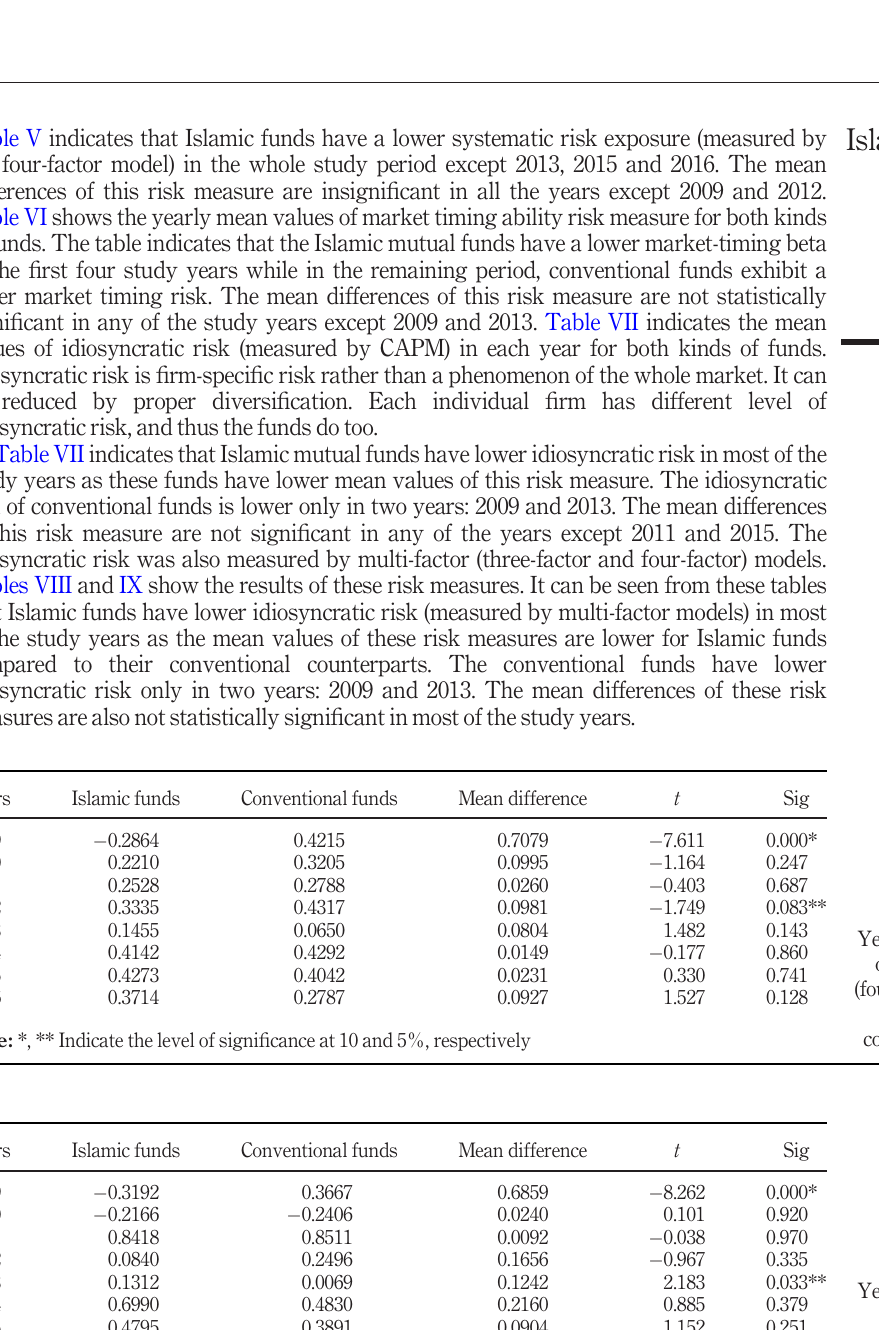
Table VI. Yearly mean values of market timing ability beta for both Islamic